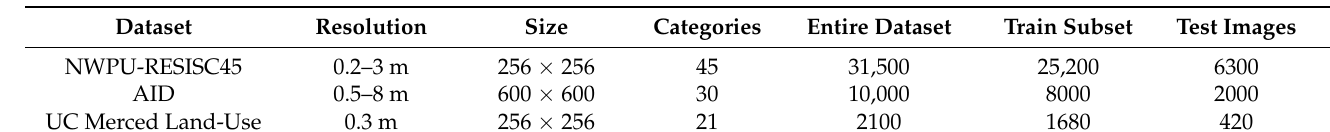
Table 1. Different datasets for RSI scene classification with the 80% training ratio. We present the detailed information of each dataset.